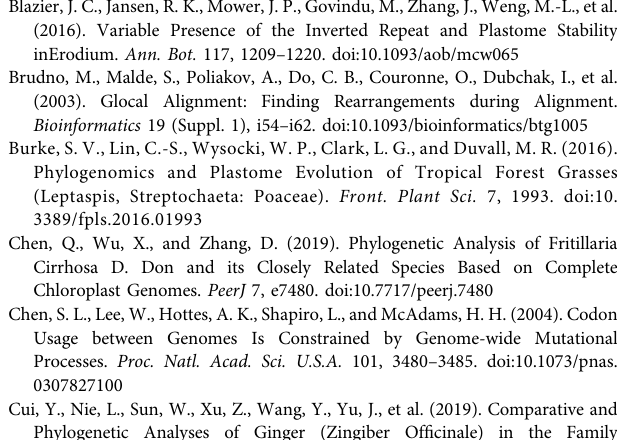
Supplementary Table S4 | Codon usage of fi ve Acer species ’ cp genomes. Supplementary Table S5 | Simple sequence repeats of fi ve Acer species ’ cp genomes. Supplementary Table S6 | Nucleotide diversity analysis